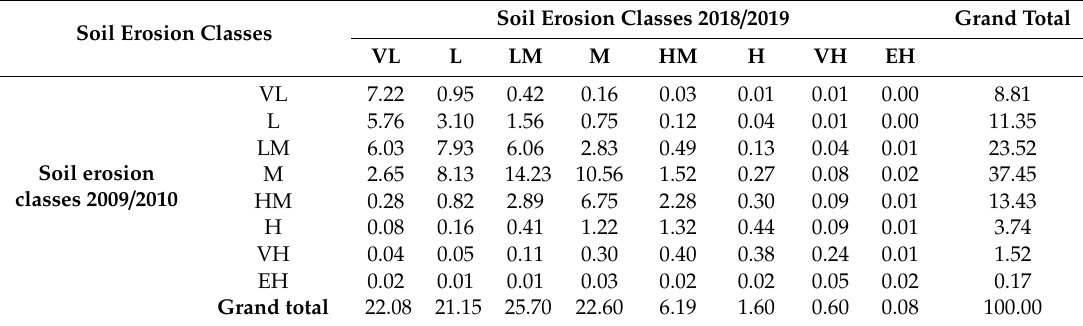
Table 4. Change the soil erosion matrix classes from 2009 / 2010 to 2018 / 2019 (%). Soil Erosion Classes 2018 / 2019 Soil Erosion Classes